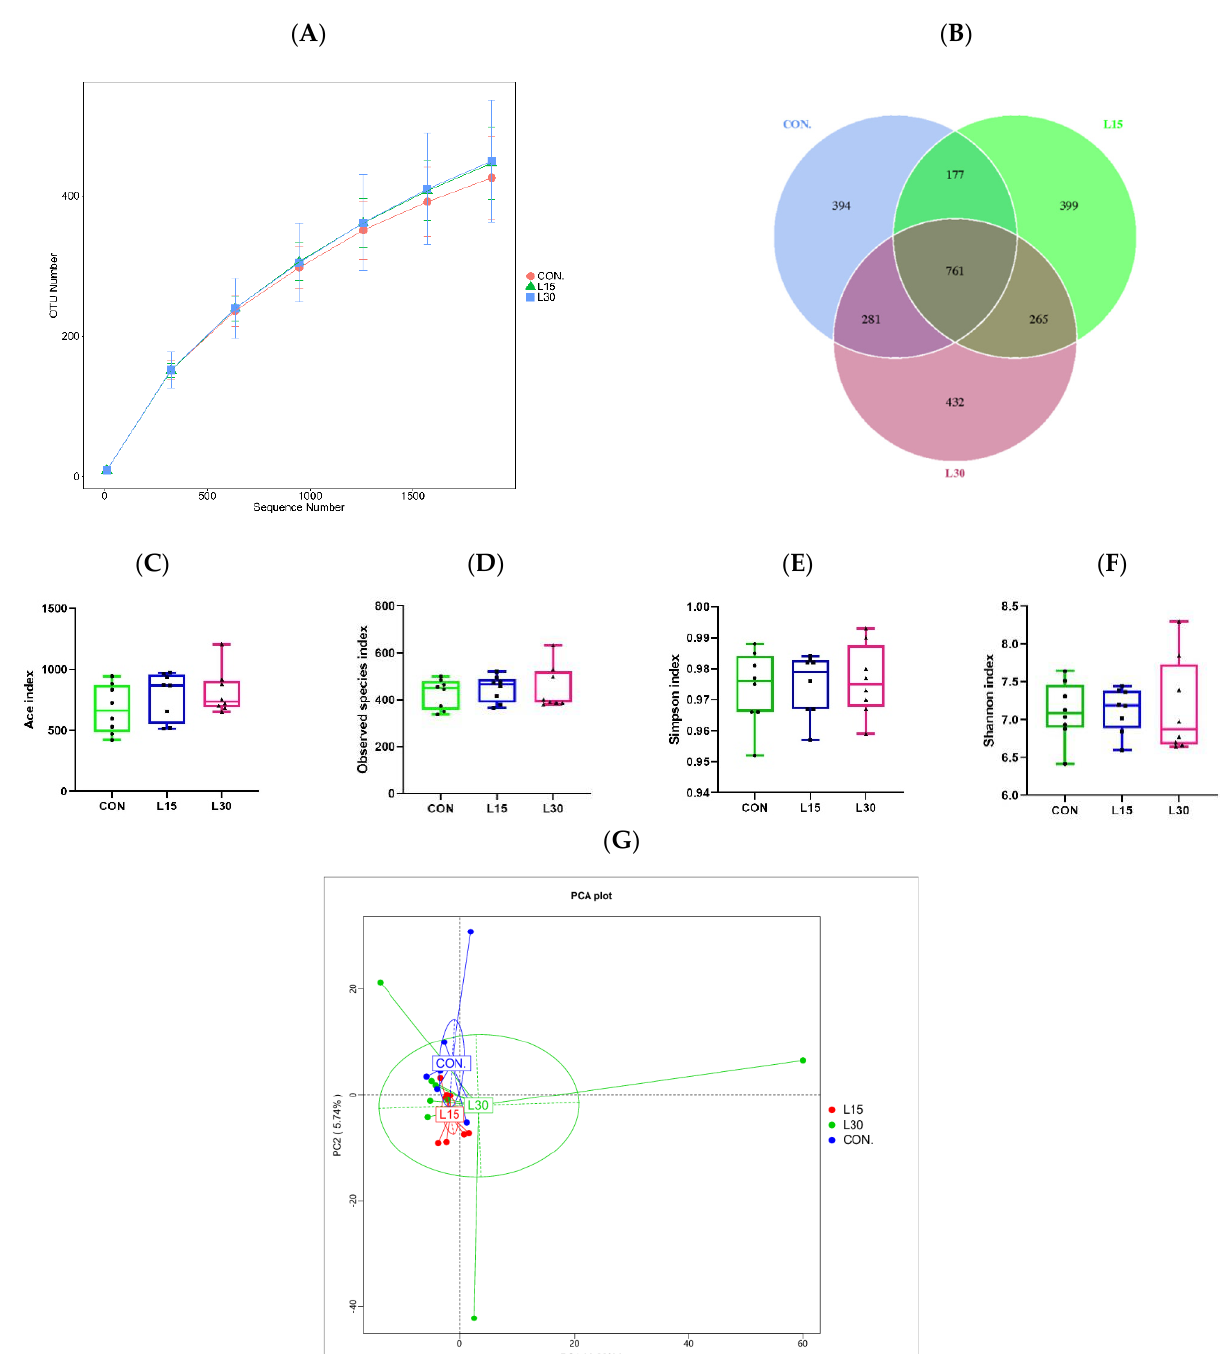
Figure 1. Sequencing depth and fecal microbiota diversity. ( A ) Group observed species; ( B ) Venn figure; ( C ) Ace index; ( D ) Observed species index; ( E ) Simpson index; ( F ) Shannon index; and ( G ) OUT, operational taxonomic unit; PCA, principal component analysis; CON, 0% FHTR in the diet; L15, 15% FHTR in the diet; L30, 30% FHTR in the diet.